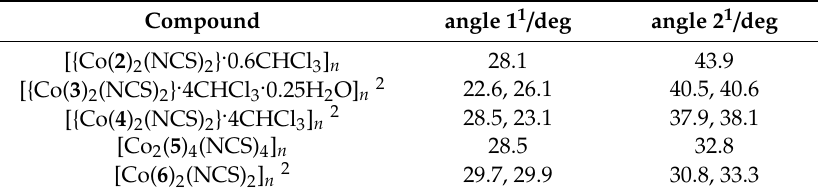
Table 2. Angles between the least squares planes of the rings in the 3,2 (cid:48) :6 (cid:48) ,3”-tpy